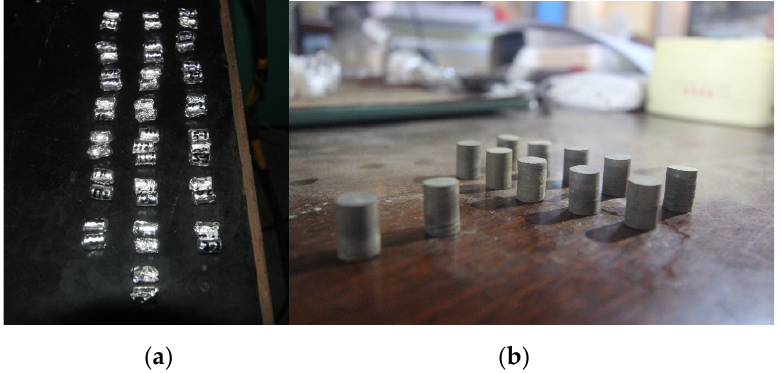
Figure 1. Oil shale samples: ( a ) Oil samples prepared for retorting muffle furnace; ( b ) Raw oil shales.